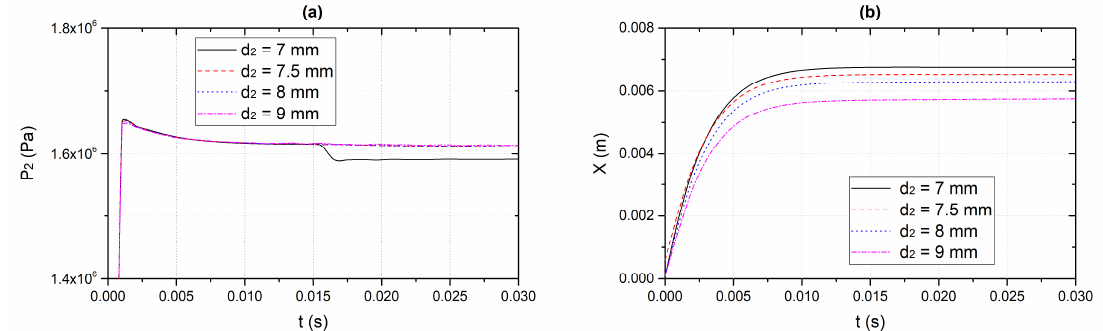
Figure 8. Effect of varying the diameter of the diversion holes ( 𝑑 (cid:2870) = 7, 8, 9, and 10 mm) on the valve start-up characteristics under 𝑞 (cid:3032) = 8 L/s and 𝑃 (cid:2869) = 1.6 MPa: ( a ) Outlet pressure 𝑃 (cid:2870) ; ( b ) poppet displacement 𝑋 . ( b ) poppet displacement X .